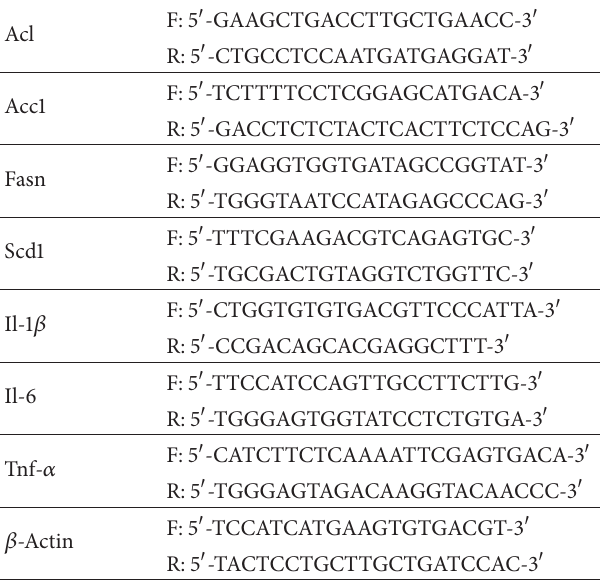
Table 1: Primer sequences for SYBR Green probes of target